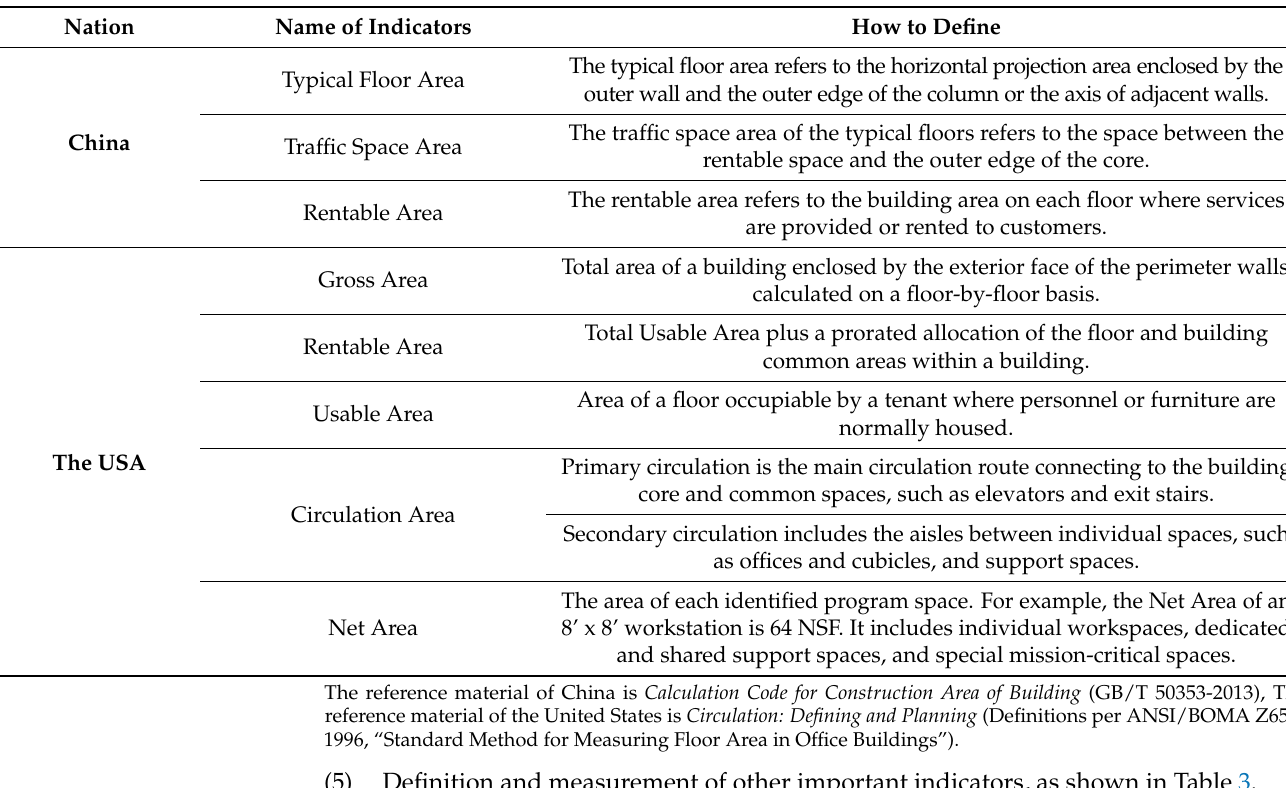
Table 3. Name of technical indicators and Technical element